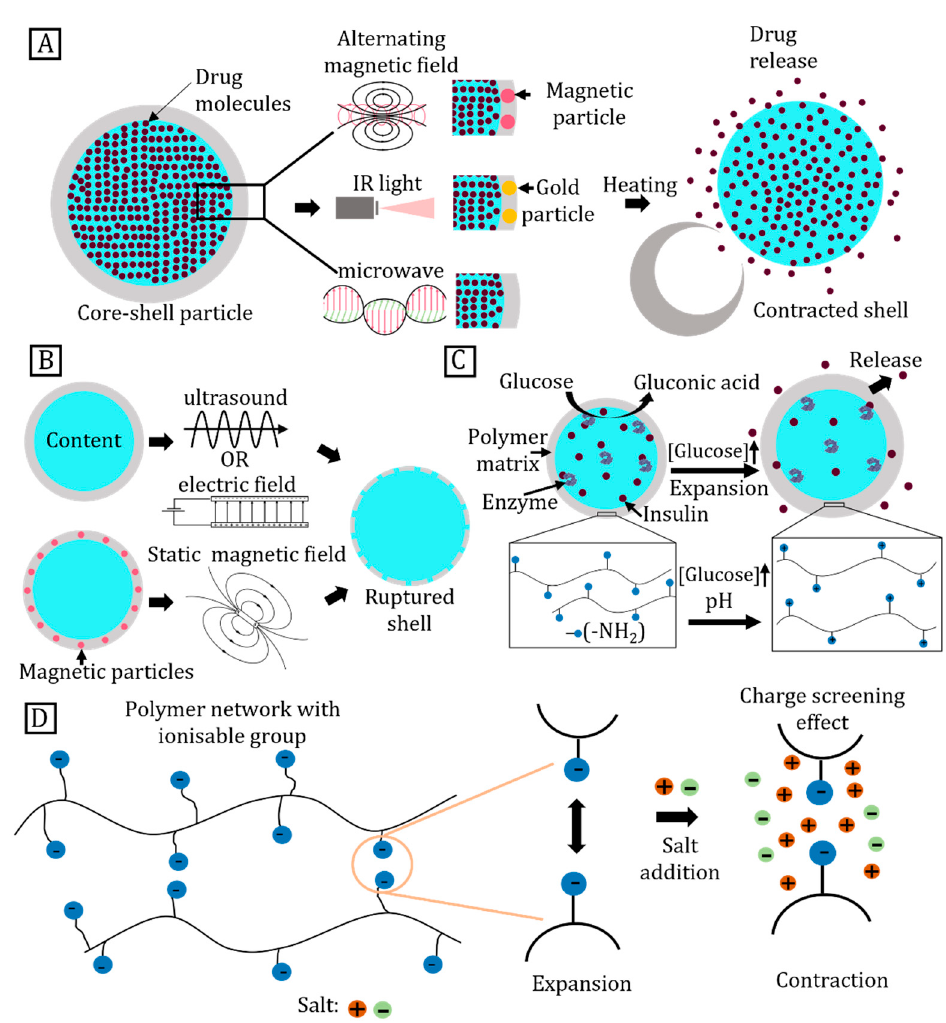
Figure 7. Triggered release of core − shell particles. ( A ) Schematics of triggered release of core − shell particles using various heating strategies; ( B ) Physical rupturing of shell; ( C ) Core − shell particles encapsulating insulin and enzyme, enzymatic action on glucose coverts it into gluconic acid, high pH causes shell expansion and triggers release; ( D ) Ionic concentration tunes electrostatic forces to control the expansion of the shell.